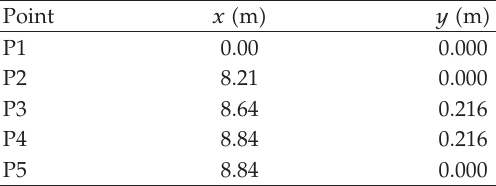
Figure 1: Sketch of CIEMito wave flume used to reproduce and understand overtopping at a low-crested maritime structure. Table 1: Model coordinates (cid:2) see Figure 1 (cid:3)